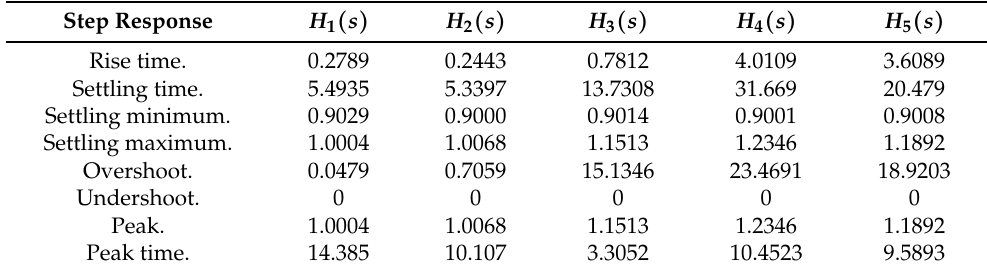
Table 3. Step responses of H 1 ( s ) , H 2 ( s ) , H 3 ( s ) , H 4 ( s ) and H 5 ( s )